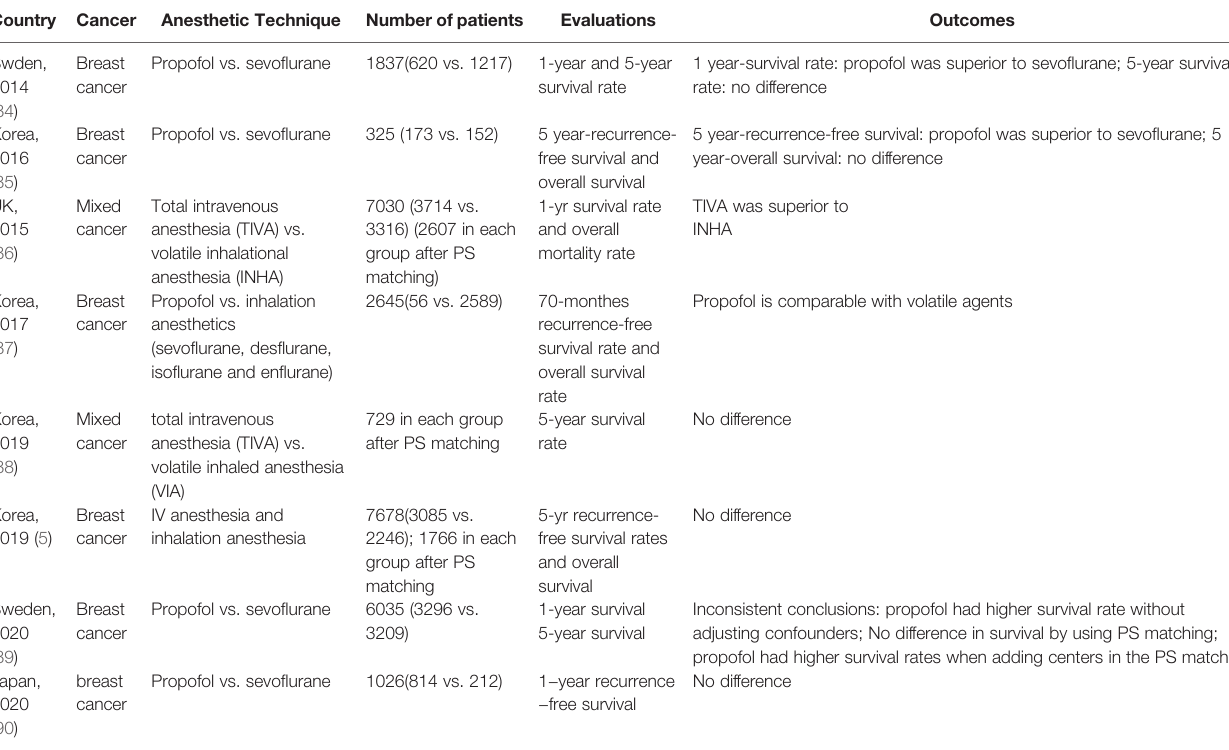
TABLE 1 | Retrospective clinical studies comparing effects of propofol versus sevo fl urane on long-term prognosis of breast cancer. Country Cancer Anesthetic Technique Number of